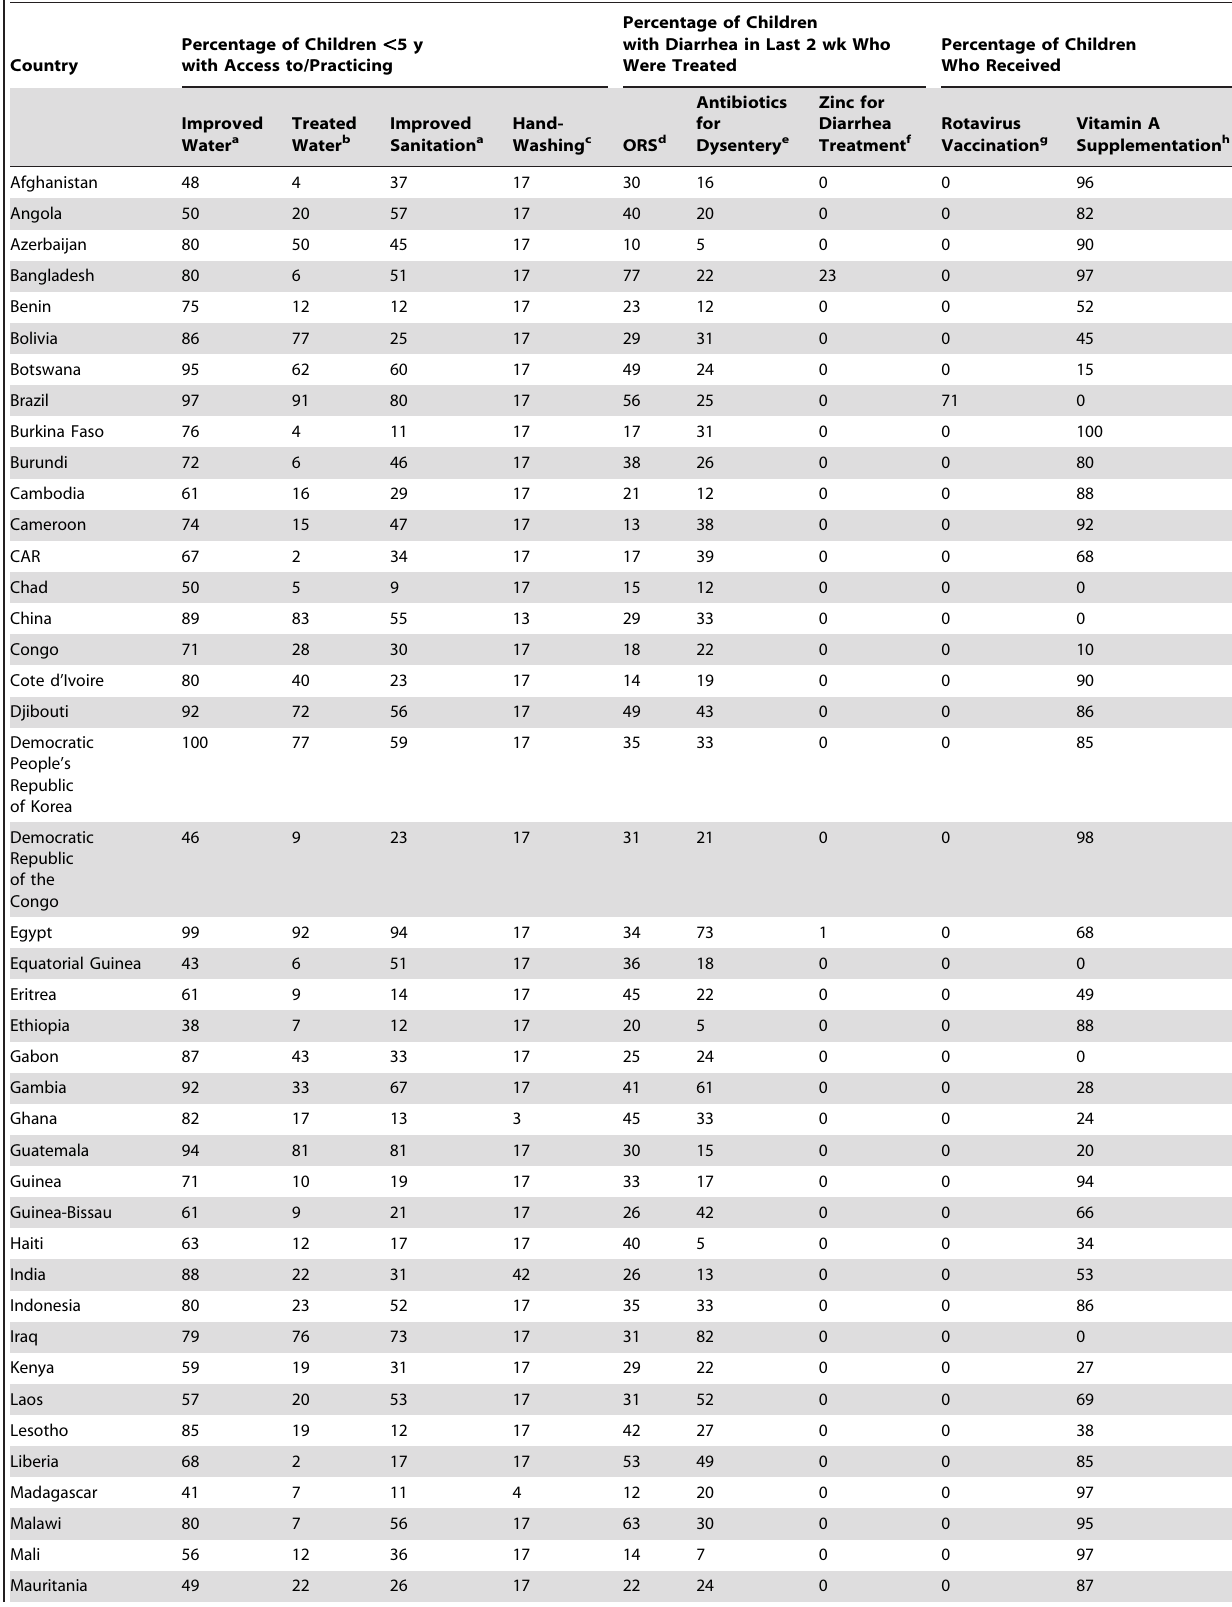
Table 1. Baseline coverage values for all interventions except breastfeeding.